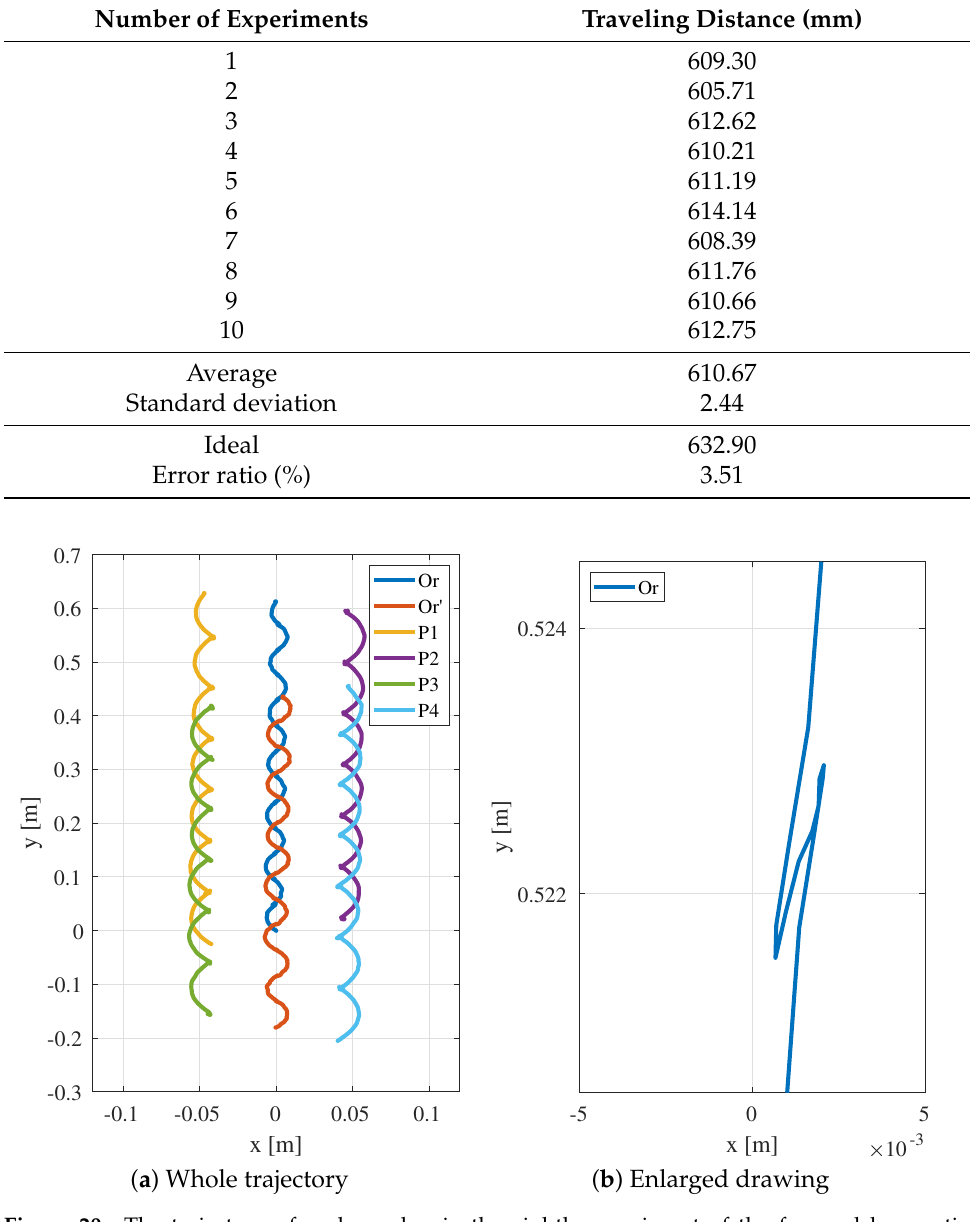
Figure 20. The trajectory of each marker in the eighth experiment of the forward locomotion experiment. ( a ) The overall view of the trajectories. ( b ) An enlarged view of the trajectory of O r . The robot coordinate O r moved backward marginally because of the flexure of the